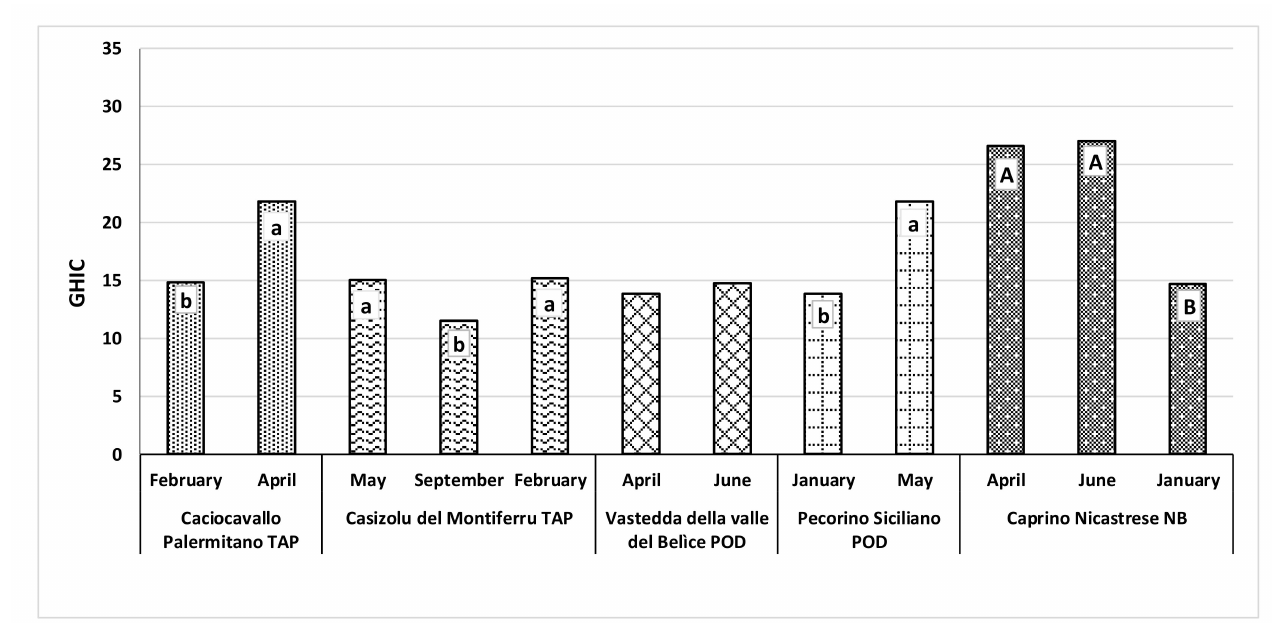
Figure 1. Effect of the month of production on the general health index of cheeses (GHIC) for the five cheeses of the AGER selection. A, B capital letters and a, b small letters within the same cheese type indicate significant differences between months of production, where p < 0.01 and p < 0.05,